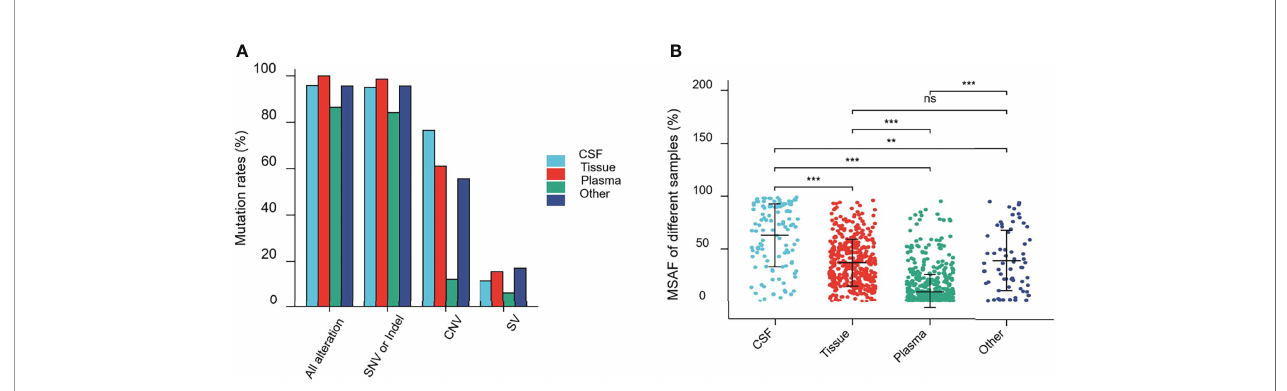
FIGURE 3 | Mutations rates and Maximal somatic allele frequency (MSAF). (A) Mutations detected in different samples from patients in this study. (B) The MSAFs of CSF, tissue, plasma, and other samples from patients in this study. ns, p ≥ 0.05; **p <0.01; ***p <0.001.